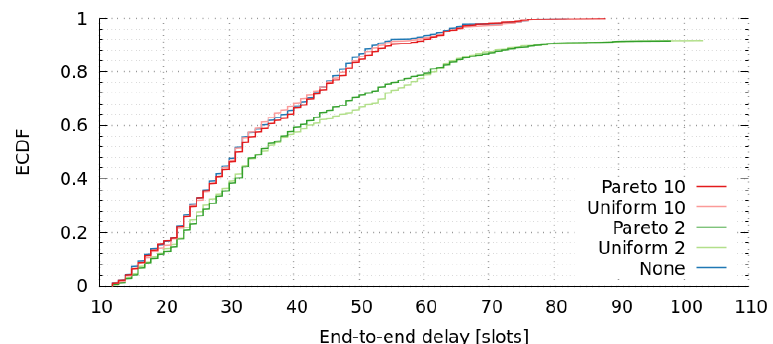
Figure 9. End-to-end message delays.